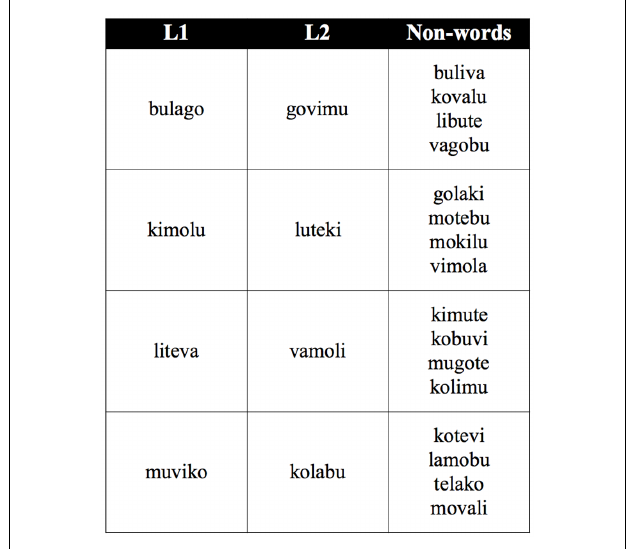
FIGURE 1 |This figure shows the design of languages L1, L2.